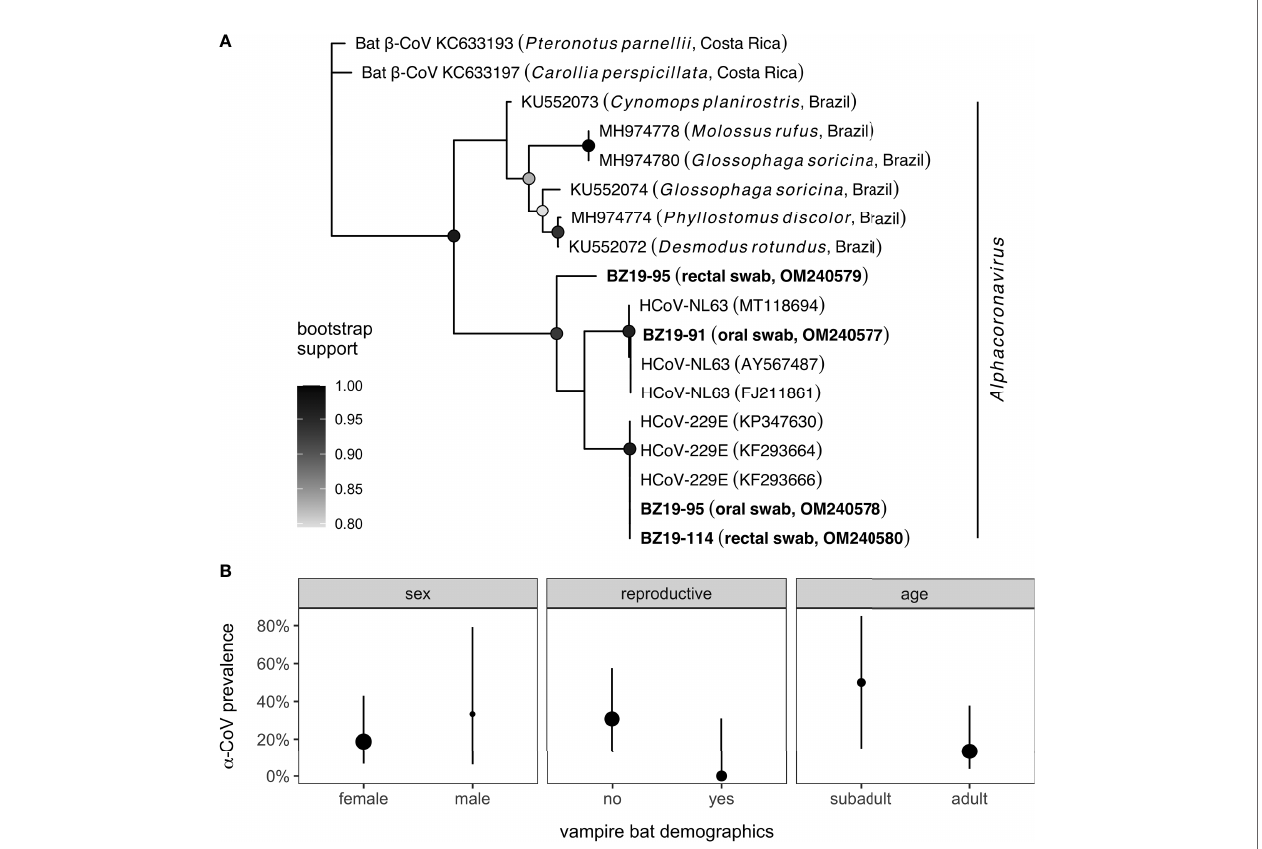
FIGURE 1 | Phylogeny and distribution of CoV infections in Belize vampire bats. (A) Sequences from PCR-positive oral or rectal swabs ( n = 4) were aligned with genetically similar (NCBI BLAST) and representative CoV sequences from other Neotropical bat species. Nodes display bootstrap support from maximum likelihood estimation; only values greater than 80% are shown. (B) Prevalence of alphacoronavirus infection in bats with paired sera samples alongside 95% con fi dence intervals (Wilson ’ s method) for key bat demographic variables. Point estimates of infection prevalence (oral and rectal swabs pooled) are scaled by sample size per